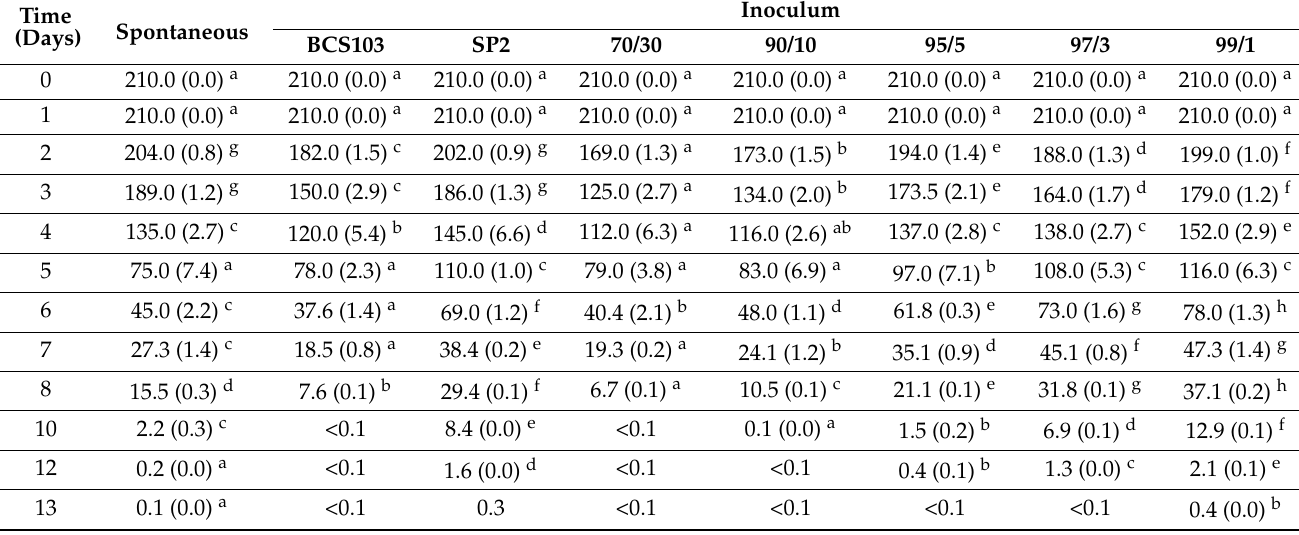
Table 2. Concentration of glucose and fructose (in g/L) during alcoholic fermentation of Sauvignon Blanc